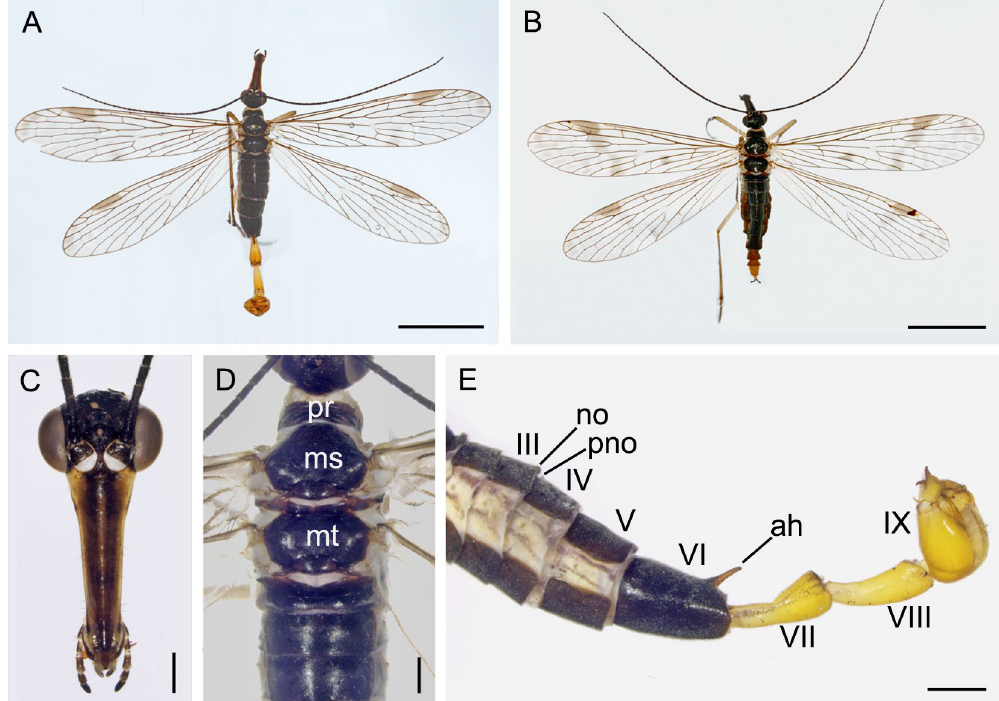
Fig. 7. Adults of Cerapanorpa taizishana sp. nov. A . Male habitus in dorsal view. B . Female habitus in dorsal view. C . Male head in frontal view. D . Dorsum of male. E . Male abdomen in lateral view. Abbreviations: ah = anal horn; ms = mesonotum; mt = metanotum; no = notal organ; pno = postnotal organ; pr = pronotum. Scale bars: A–B = 5 mm; C–E = 0.5